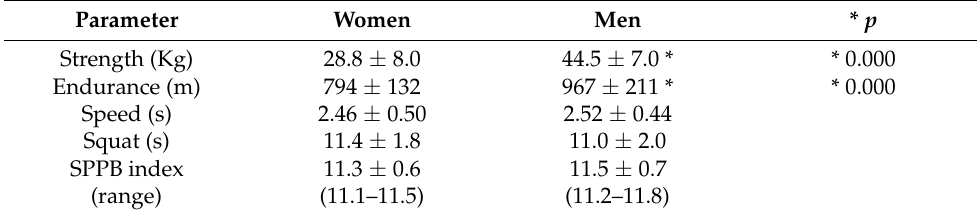
Table 5. Parameters of physical activity tests at the beginning of